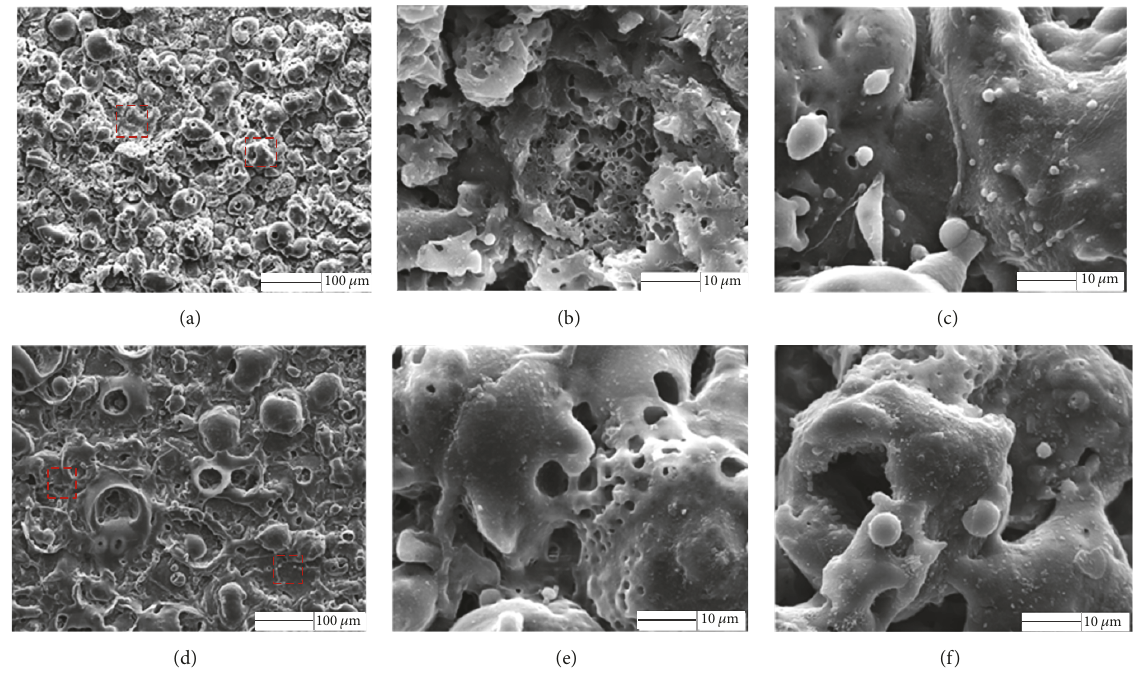
Figure 15: Surface morphology of the A356 alloy after 15min: (a) and (d) are, respectively, SMAO (interelectrode gap 5 mm, zero velocity) and MAO; (b) and (c) are the high magnification of the dotted rectangle area; (e) and (f) are the high magnification of the dotted rectangle